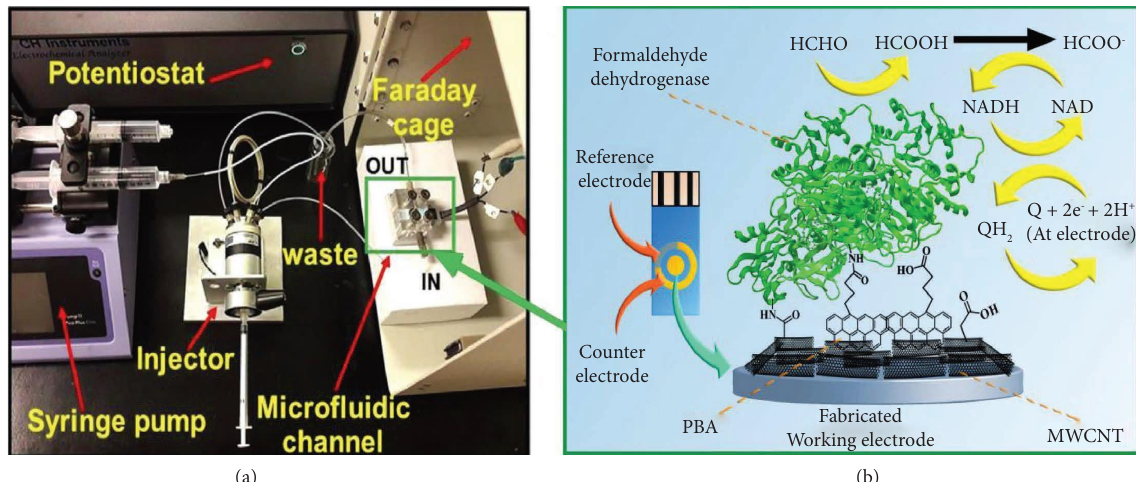
Figure 3: (a) Schematic of the microfuidics system and (b) surface modifcation of AuSPEs and the procedure for detecting HCHO by fow injection or stirring solution amperometry (redrawn from